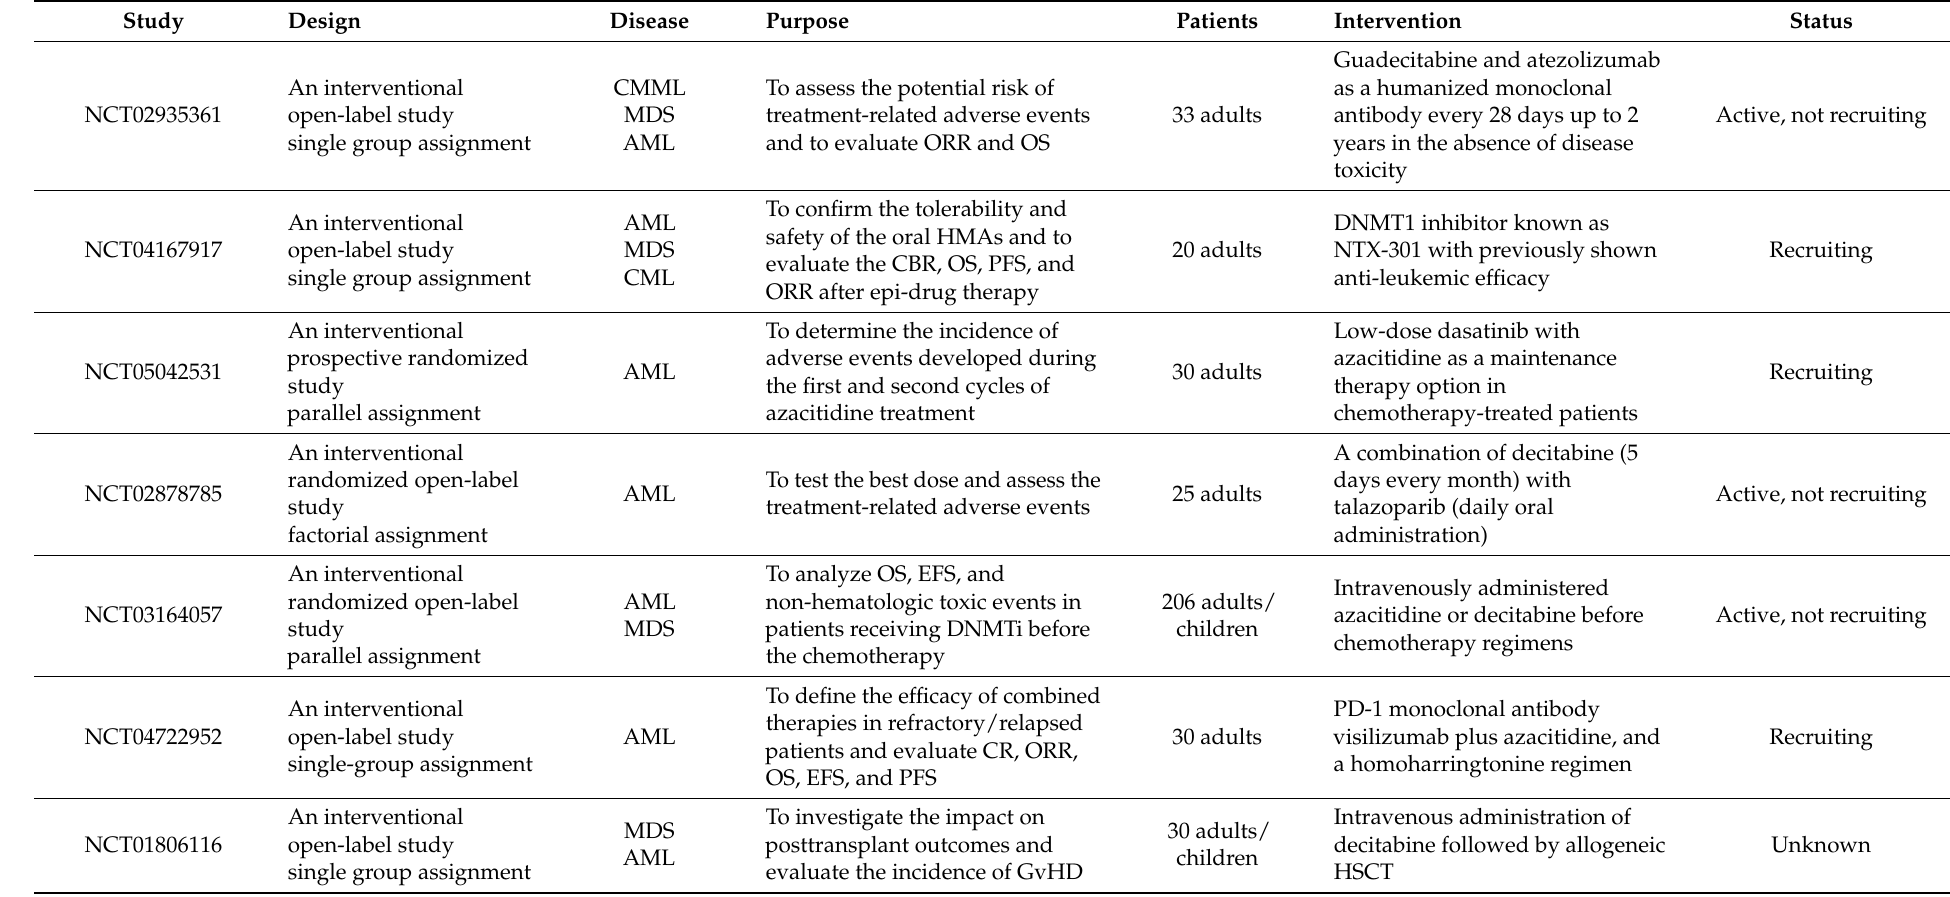
Table 1. The effect of hypomethylating agents on outcomes of patients with leukemias and myelodysplastic syndromes. The table summarizes the list of active and recruiting clinical trials focused on adverse events, treatment efficacy, EFS, PFS, OS, and ORR (according to https://clinicaltrials.gov/ and https: //beta.clinicaltrials.gov/, accessed on 1 December